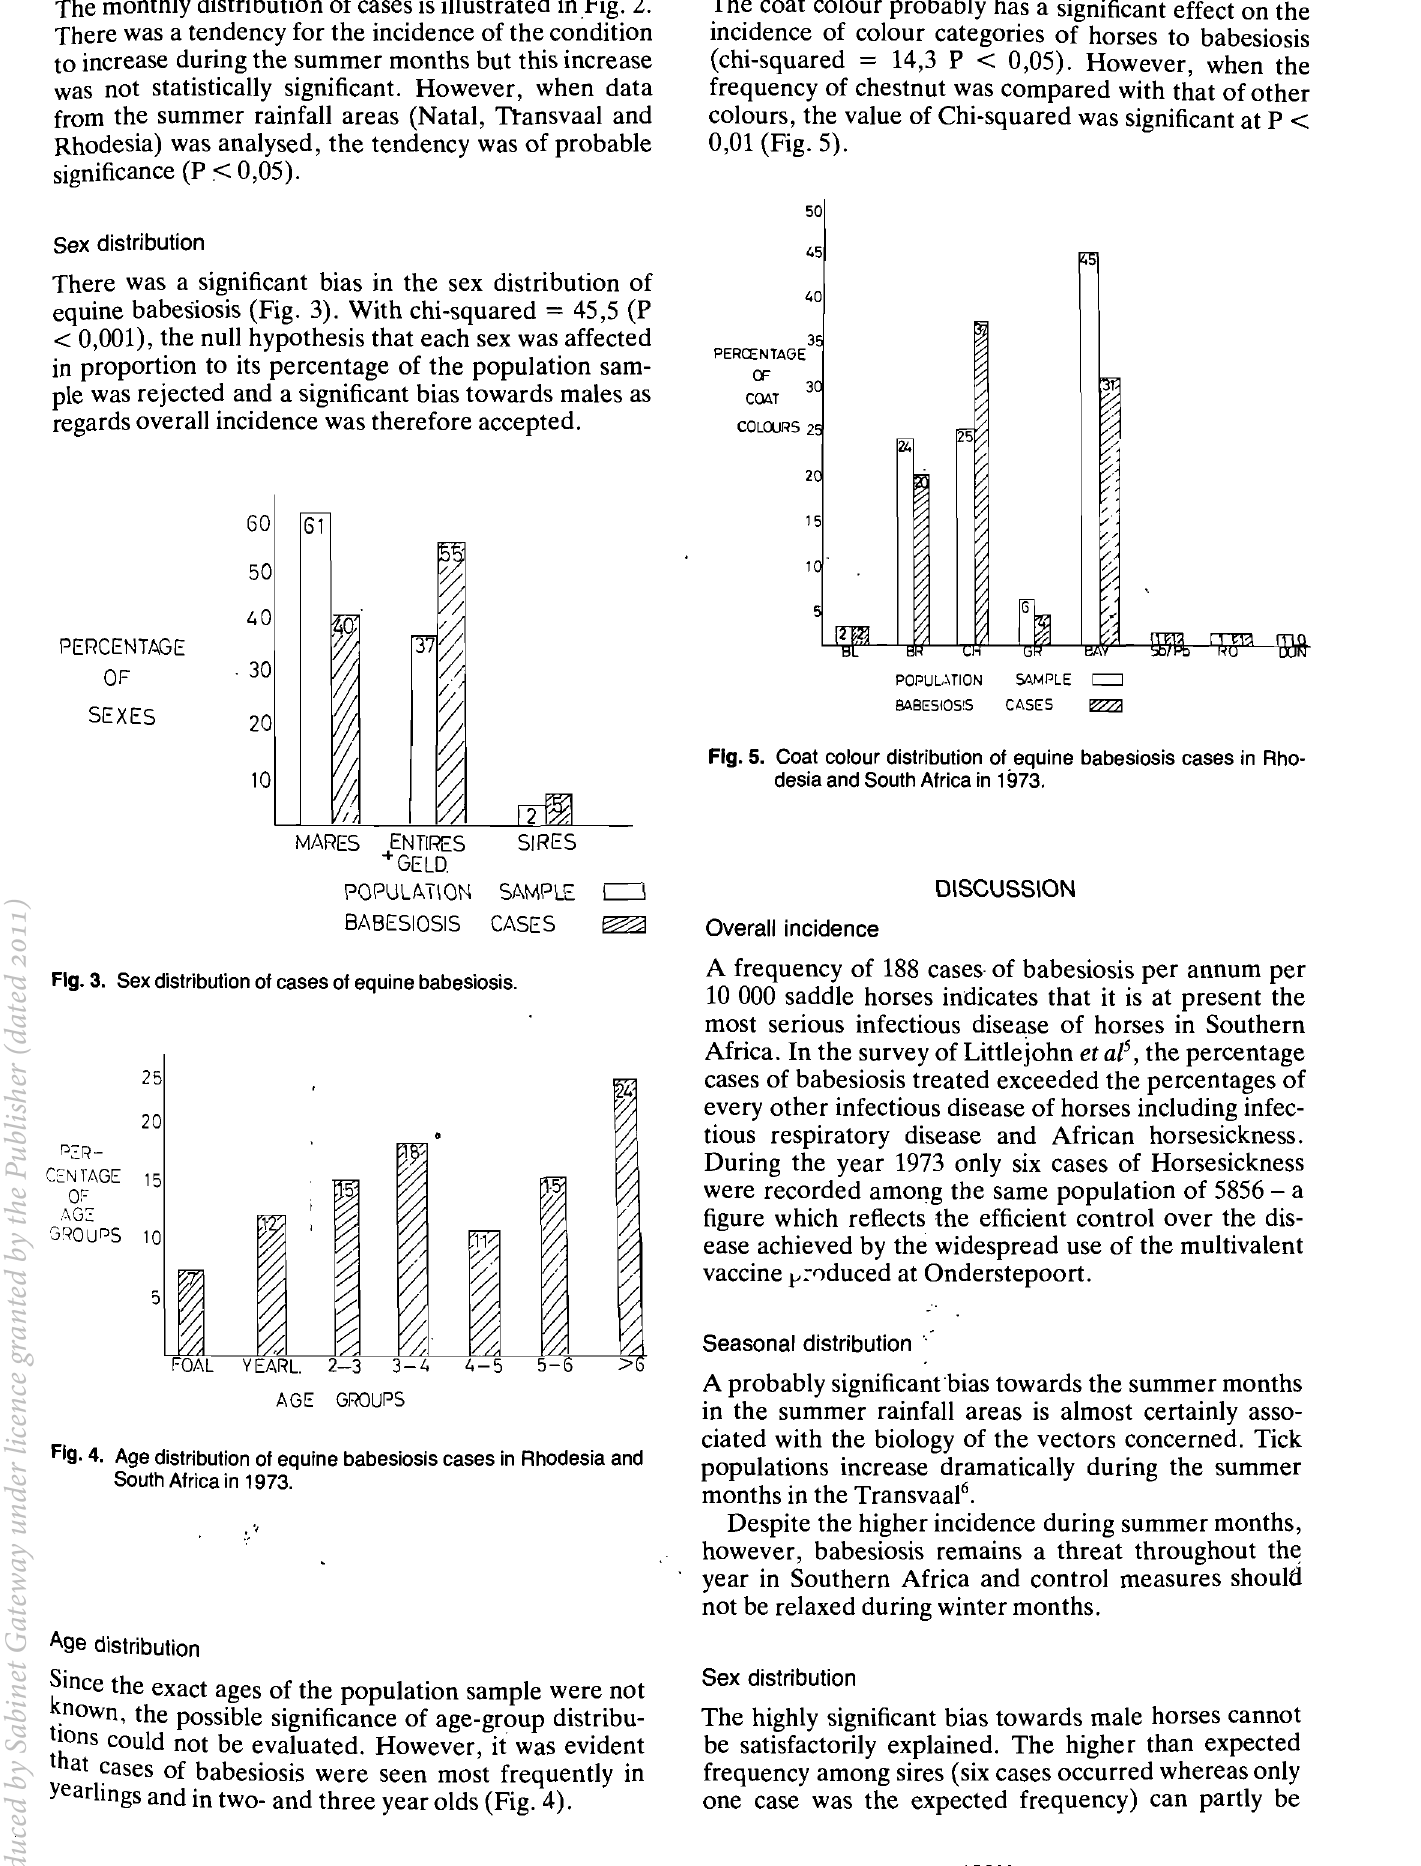
Age distribution